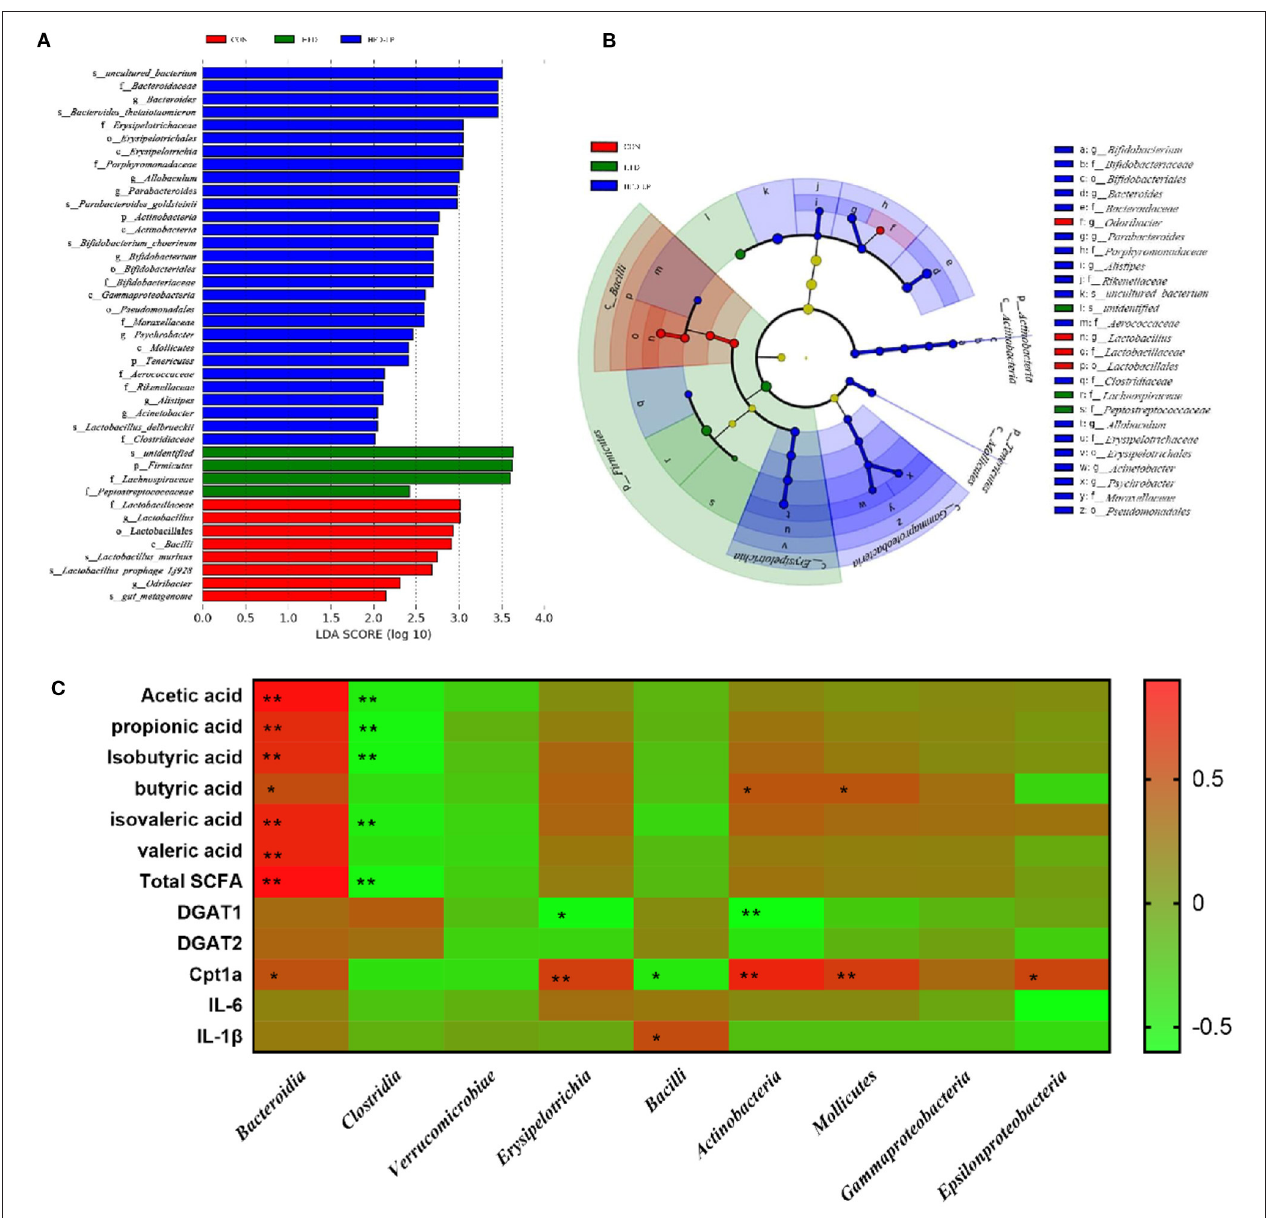
FIGURE 7 | Characteristic of mouse colon microorganisms determined by intragastric administration of Lactobacillus plantarum . (A) LDA score, an LDA score higher than 2 was considered to be an important contributor to the model; (B) LEfSe taxonomic cladogram, different colors suggest enrichment of certain taxa in the control group (red), HFD group (blue) and HFD-LP group (green). (C) Analysis of correlations between SCFAs levels, lipid metabolism-related genus level and intestinal microbe